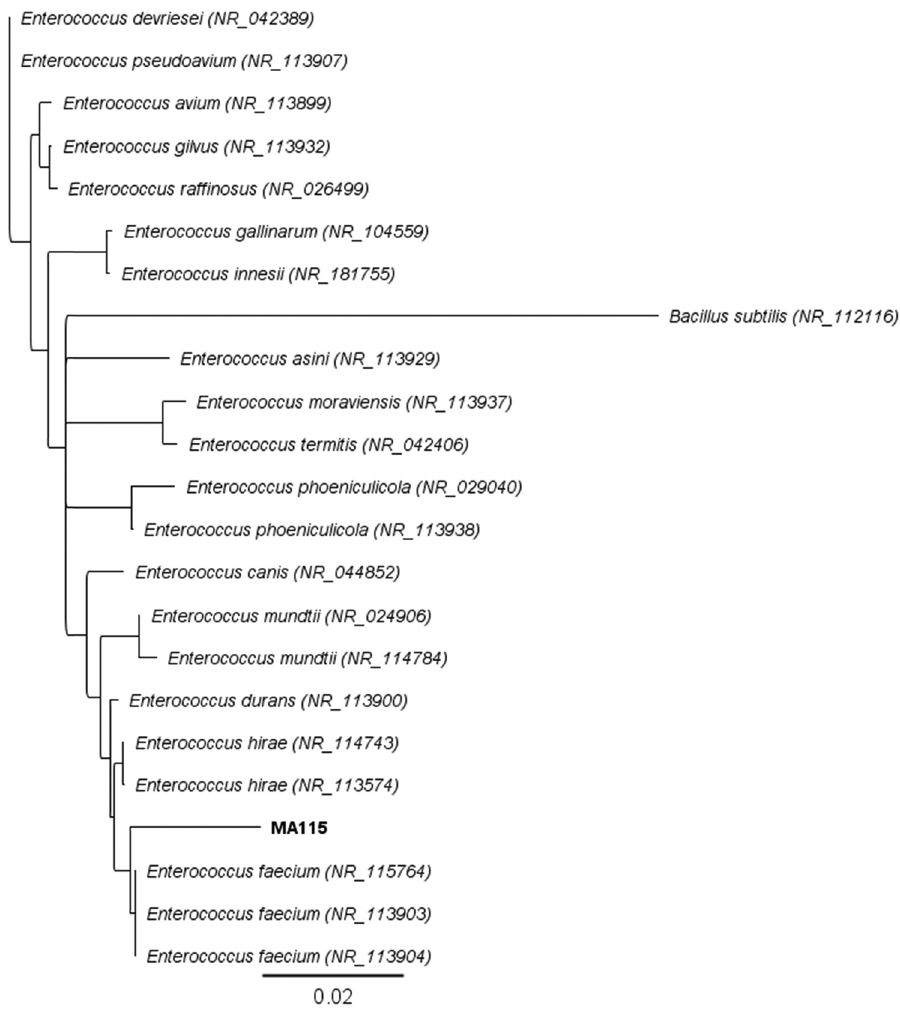
Figure 2: Phylogenetic tree of anti - listeria compound producing E. faecium MA115 isolated from the gastrointestinal tract of gilthead seabream. Bracket ( NR_... ) after the species name is the accession number in the gene